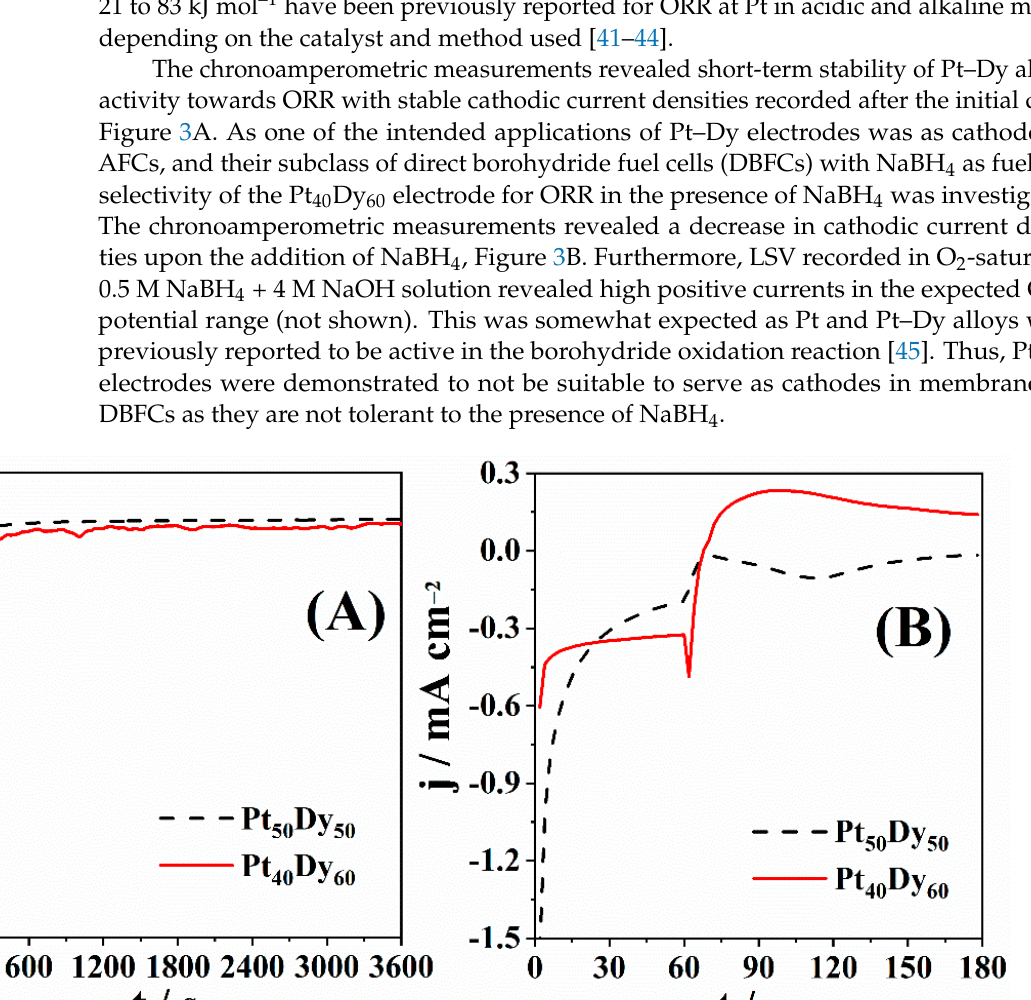
Additionally, the Pt–Dy alloys were examined for OER in alkaline media, and the